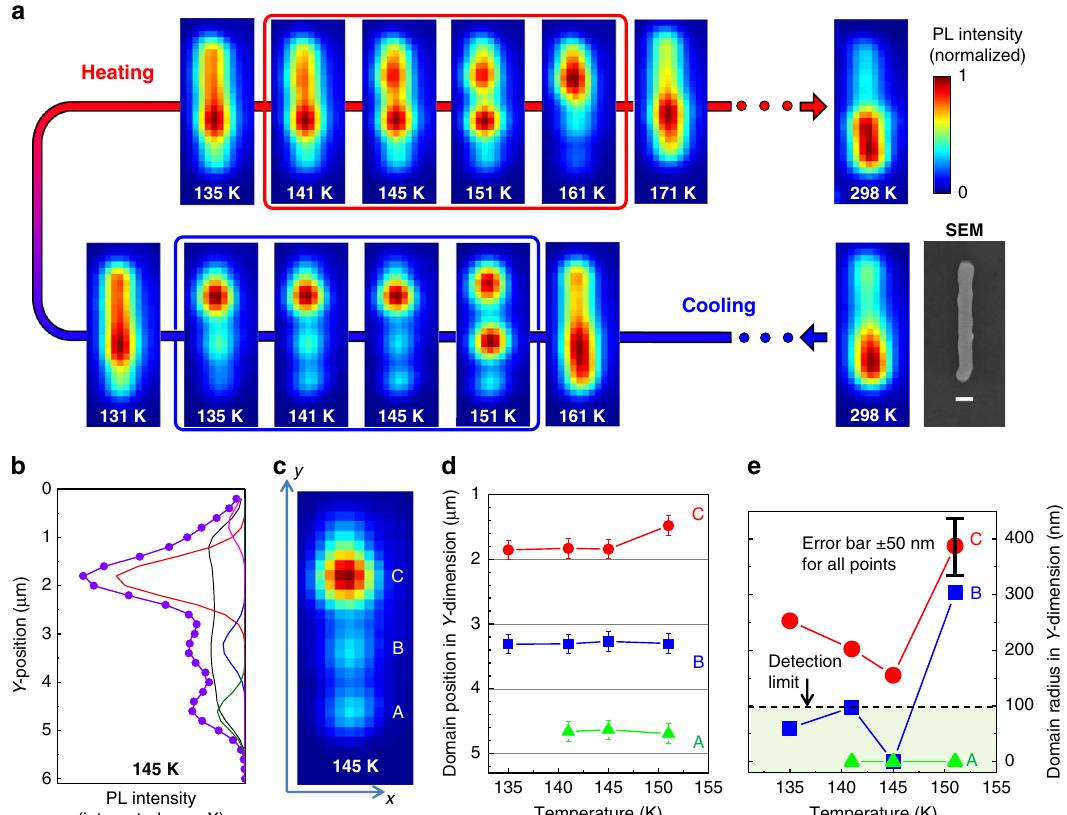
Fig. 3 Evolution of the PL intensity distribution over the nanowire NW#1. a PL images of the NW at different temperatures during the cooling and heating cycles; the scale bar shown in SEM image is 500 nm. b Fitting of the PL intensity distribution at 145 K along the NW ( y-axis ) with four Gaussian peaks representing four emitting regions of the tetragonal phase and a background ( black line ) coming from the orthorhombic phase (see Supplementary Note 3, Supplementary Figs. 5, 6). The violet dots represent the original data and the violet line the overall fi t. c Luminescence image of the NW at 145 K showing the tetragonal domains A – C; the color chart is the same as for images in a . d , e Temperature variation of the position and the characteristic radius of the domains A – C along the y-axis as a function of temperature in the cooling cycle (Supplementary Note 4). All data points in d have the same absolute error bar ( ± 50 nm) as, for the sake of clarity, is shown for one data point only. The error bars in d , e were calculated taking into account the noise of the data